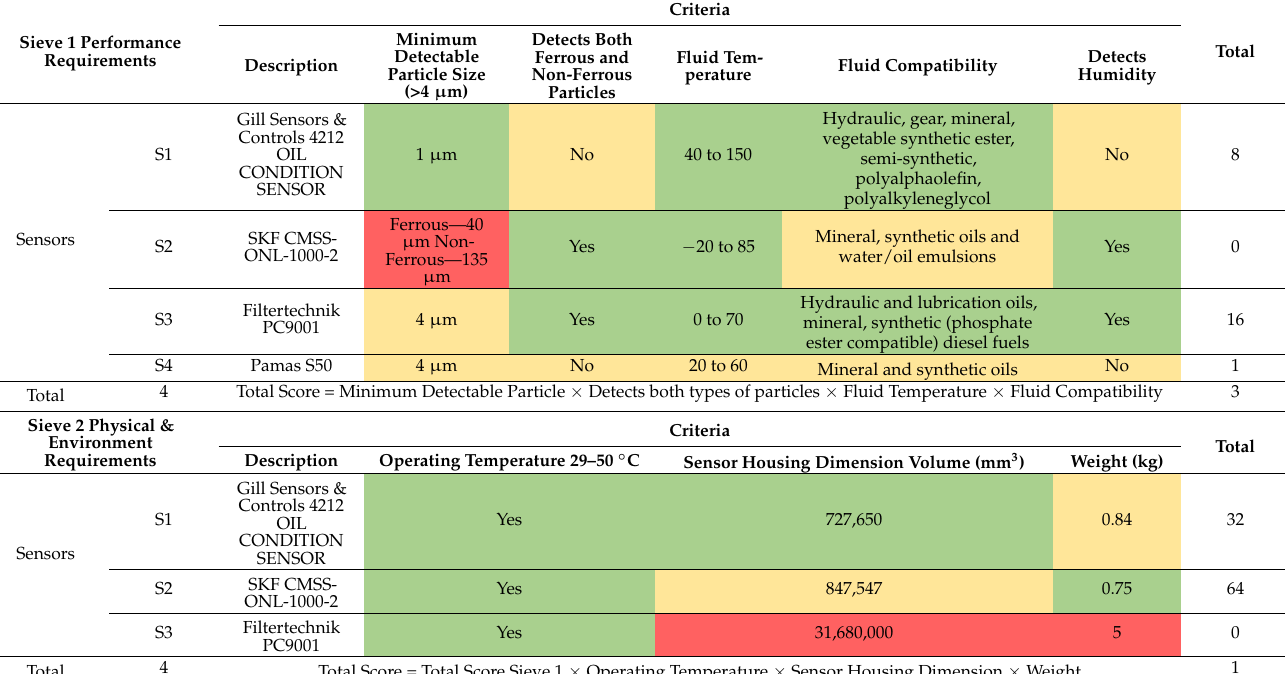
Table 9. Selection of an oil sensor using the two-sieve